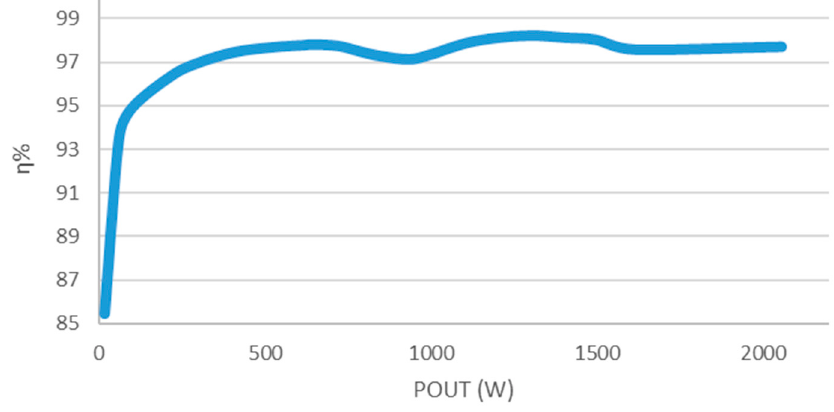
Figure 20. System efficiency at 300 kHz switching frequency.